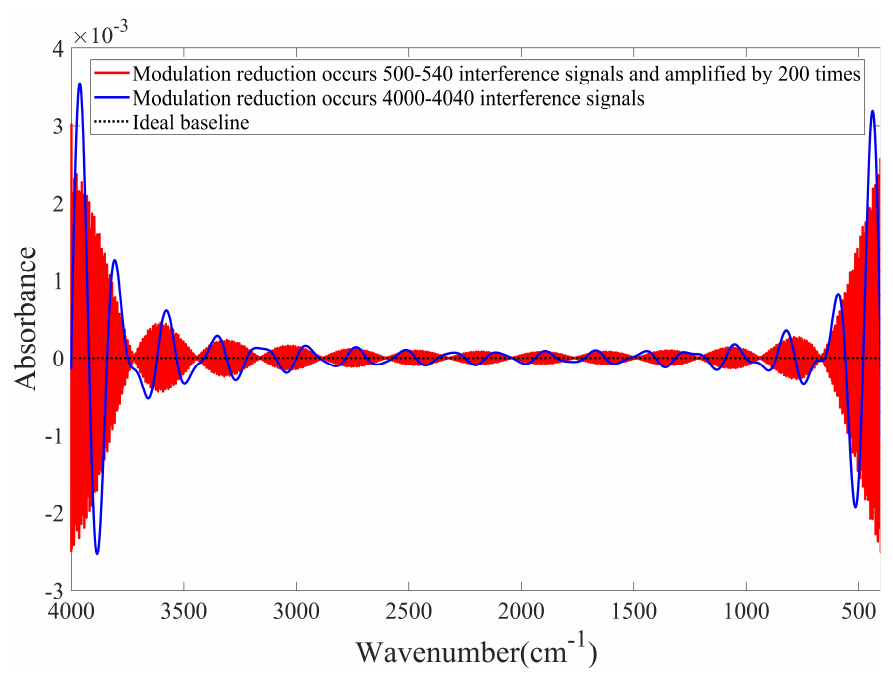
Figure 7. Baselines were obtained when the interferometer modulation is reduced to 0.95 and 0.9. Figure 7 clearly indicates that when the modulation changes temporarily, the base- line is distorted to different degrees. If the modulation change occurs near the region of zero optical path difference, the baseline fluctuates significantly. In addition, the fluctua- tion amplitudes in the high- and low-wavenumber regions are larger than those in the medium-wavenumber region because the interference signal is the strongest near the re- gion of zero optical path difference; the interference signal near the region of zero optical path difference is significantly influenced when the interferometer modulation changes. Similarly, when the baseline is distorted, it is approximately sinusoidal. 2.4. Laser Wavelength Change The interference signals are sampled according to the laser wavelength; in the simu- lation, the laser wavelength varies from 849.9 to 850.1 nm and 849.5 to 850.5 nm. The sim- ulation results are presented in Figure 8.